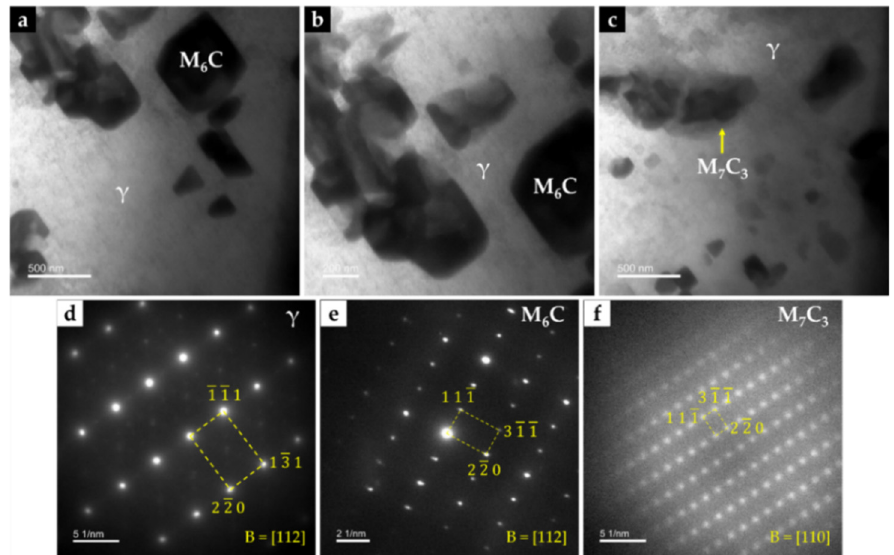
Figure 21. Bright-field TEM image of the CZ3 composite zone: ( a ) (Fe,W,Cr) 6 C with a cuboid shape precipitated within γ matrix, ( b ) higher magnification of ( a ), showing an agglomerate of (Fe,W,Cr) 6 C carbides, and ( c ) (Fe,Cr,W) 7 C 3 precipitated within γ matrix. SAED patterns were achieved by using the ( d ) [112] zone axis for γ , ( e ) [112] zone axis for (Fe,W,Cr) 6 C, and ( f ) [110] zone axis for (Fe,Cr,W) 7 C 3 .